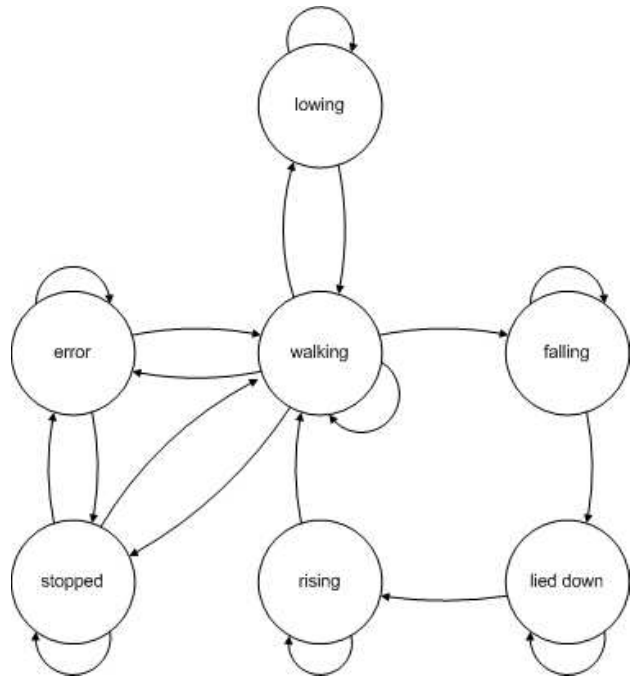
Figure 8. Structure of the HMM used in experiment